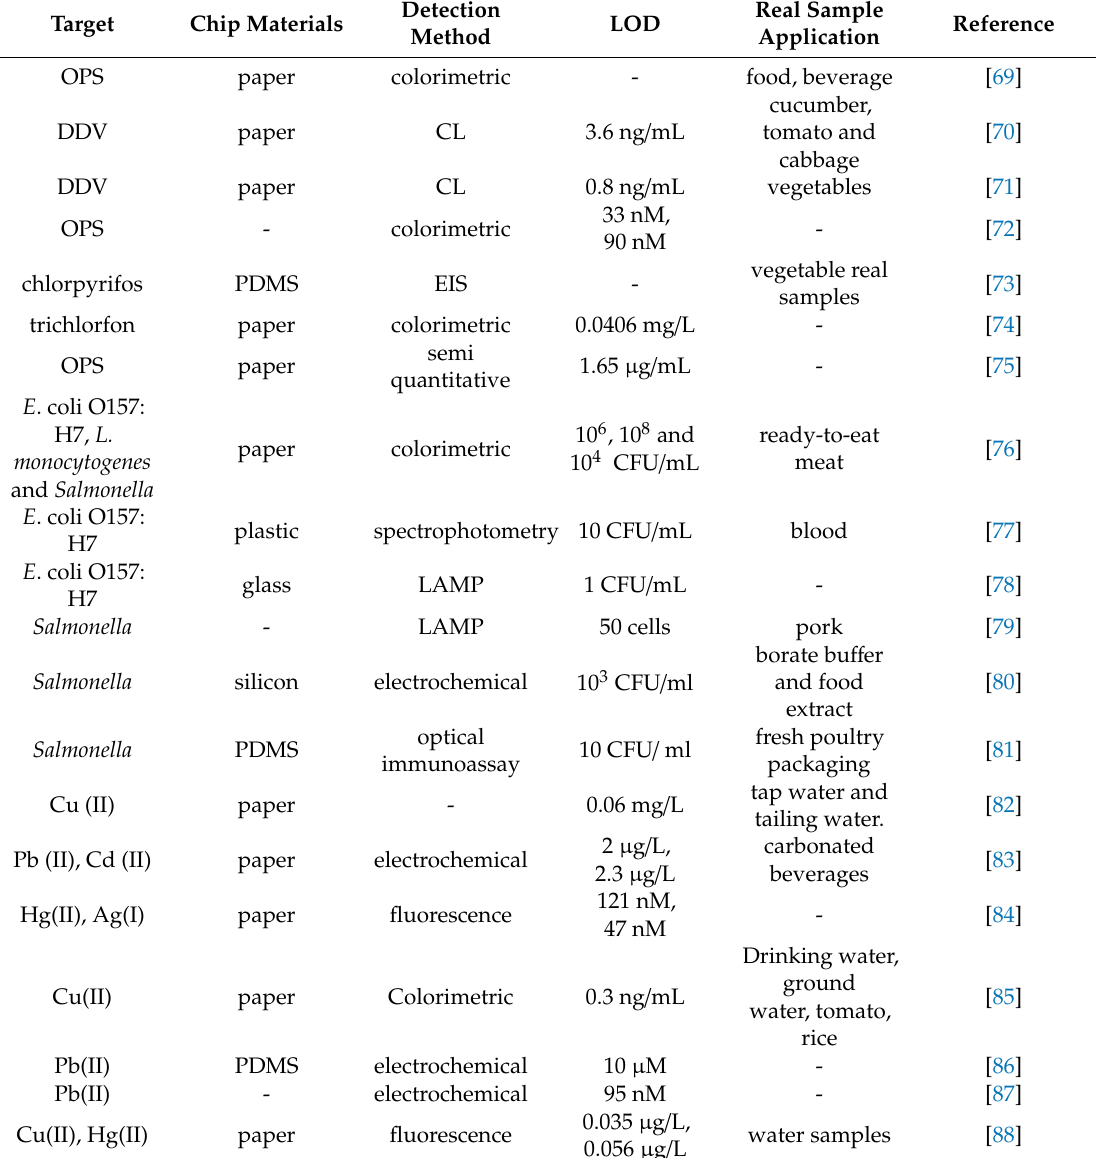
Table 1. Summary of microfluidic chip technology in food safety